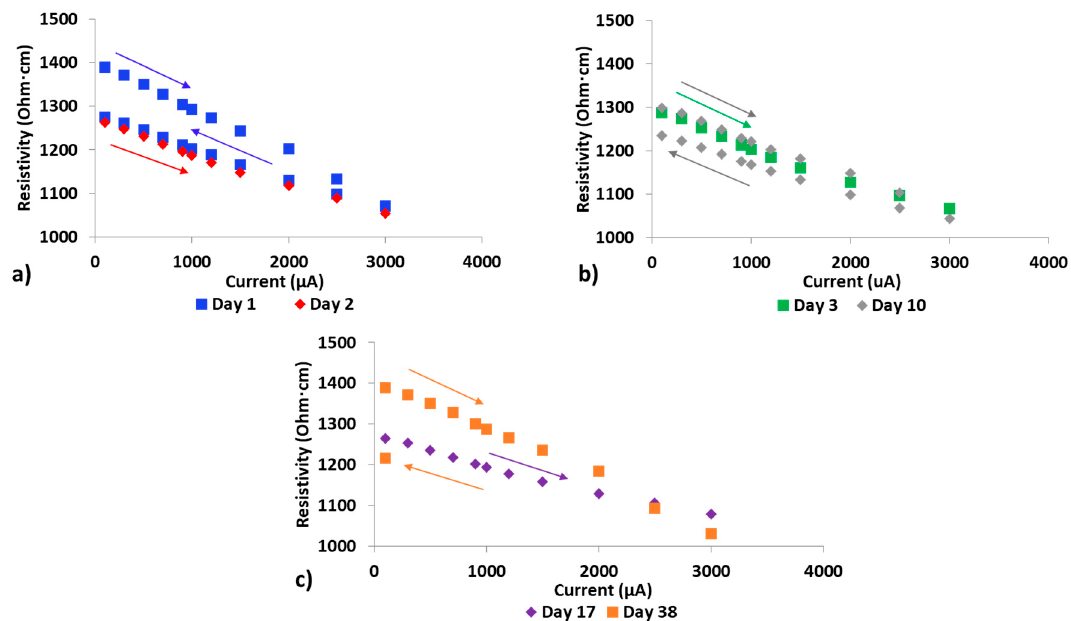
Figure 4. ( a ) 0.014 wt% sample subsequent day resistivity change; ( b ) 0.014 wt% sample one week resistivity change; ( c ) 0.014 wt% sample three week resistivity resistivity change; ( c ) 0.014 wt% sample three week resistivity change .